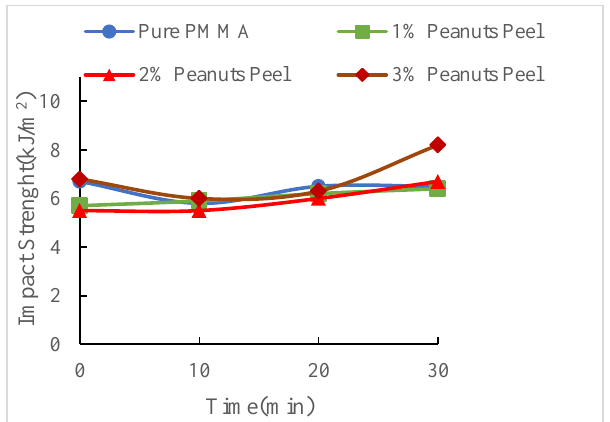
Fig.8: Influence of immersion nanocomposite PMMA + (1%, 2%, 3% of Peanuts Peel) in natural Lemon for (10, 20, 30 min), respectively.